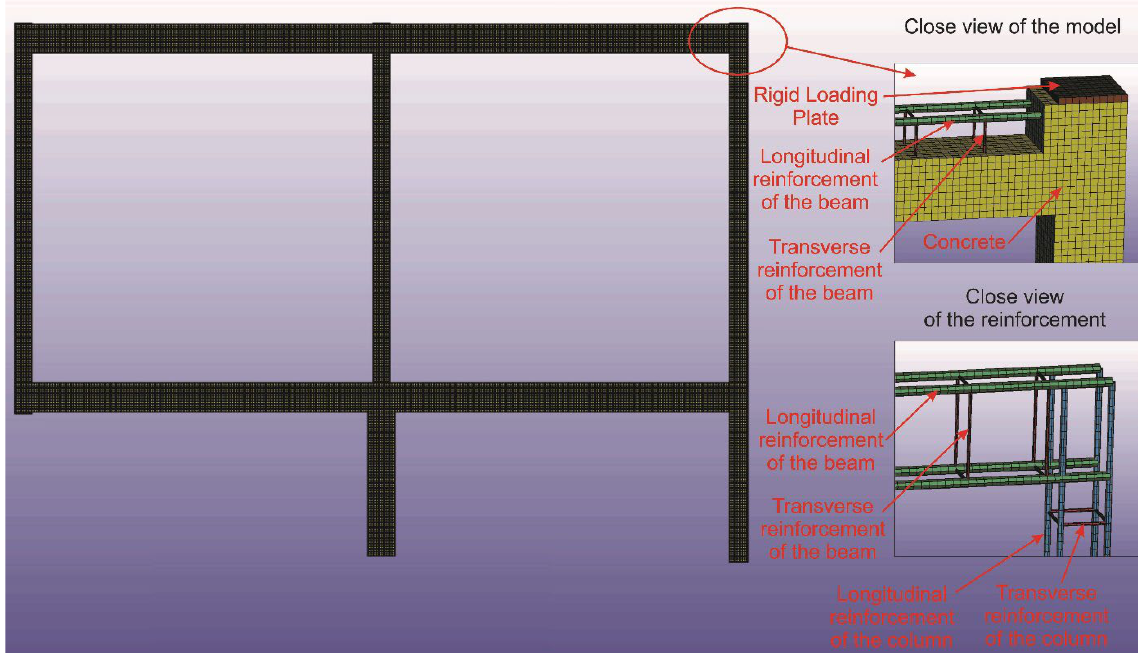
Figure 13. Finite element model of the test frame developed using Ls-dyna software.